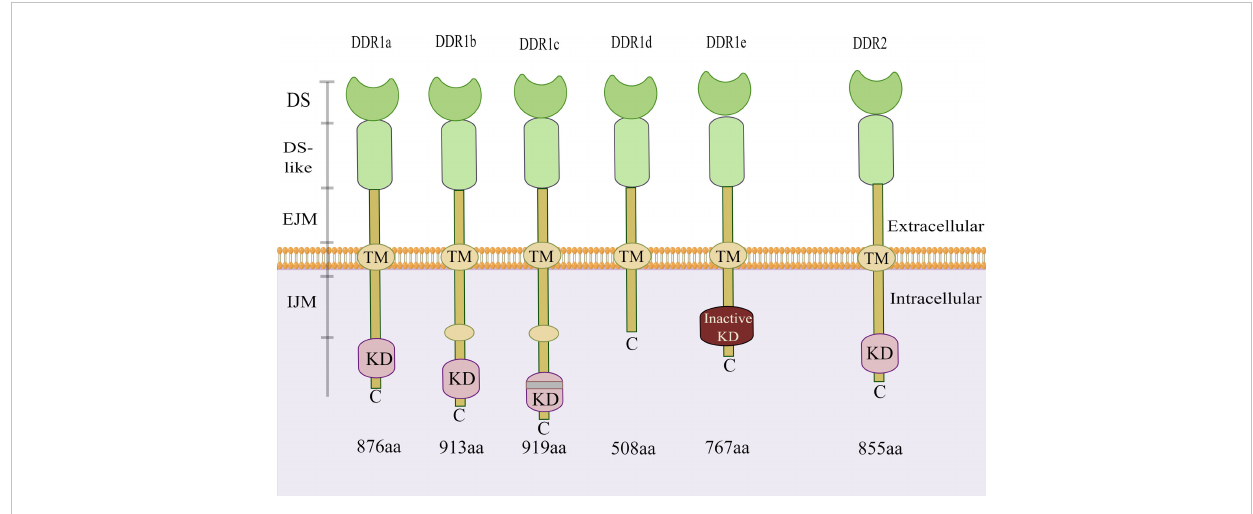
FIGURE 1 Structure of DDR1 and DDR2. There are fi ve isoforms of DDR1. Among them, the kinase activity is present in the DDR1a, DDR1b and DDR1c coding sequences, but not in the DDR1d or DDR1e. However, only one single isoform of DDR2 exists. DDR, discoidin domain receptor; DS, discoidin domain; EJM, extracellular juxta-membrane; IJM, intracellular juxta-membrane; KD, kinase domain; TM, transmembrane domain. (The fi gure is drawn by